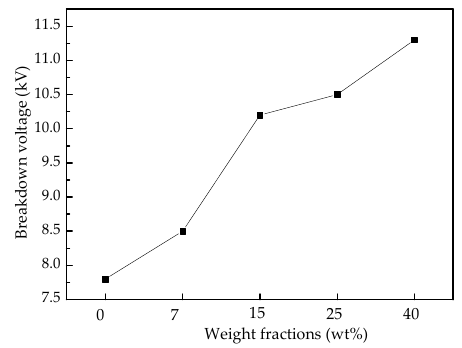
Figure 13. Surface breakdown voltage of nanocomposites with different weight fractions.